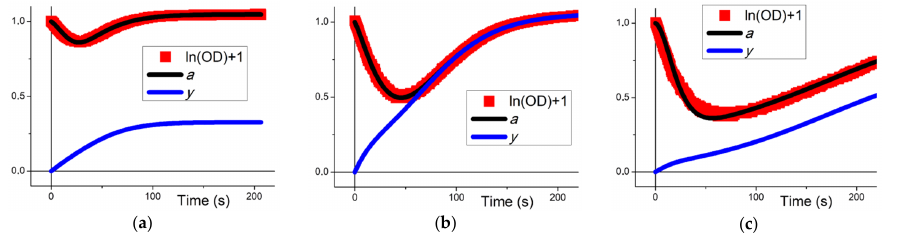
Figure 2. Fitting of Equation (3) to experimental data on platelet aggregometry in response to ADP. ( a – c ) Five parameters of Equation (3) were fitted by means of the “Particle Swarm” parameter estimation method to describe experimental data of platelet aggregation in response to ADP at 2.5 μ M ( a ), 5 μ M ( b ), or 10 μ M ( c ). Blue lines denote variable y , black lines denote variable a , red squares denote the logarithm of experimental OD values. Experimental data are typical curves from n = 10. Table 1. Estimated parameter values for Equation (3) for experimental datasets presented in Figure 2.